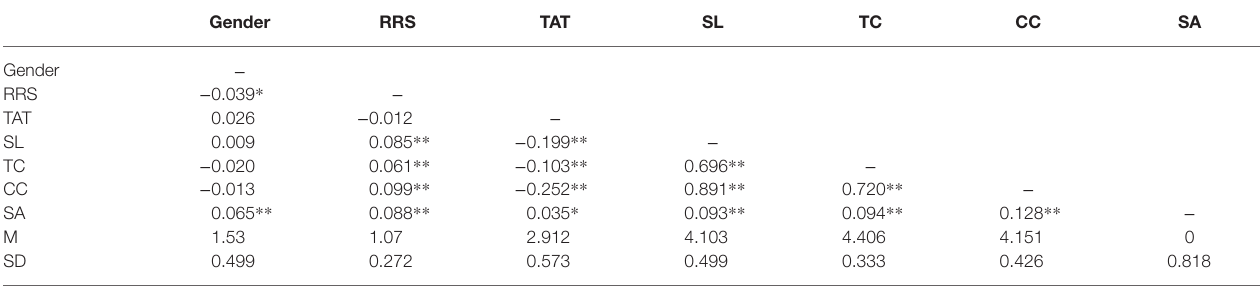
TABLE 1 | Descriptive statistics and Pearson correlations among study variables.